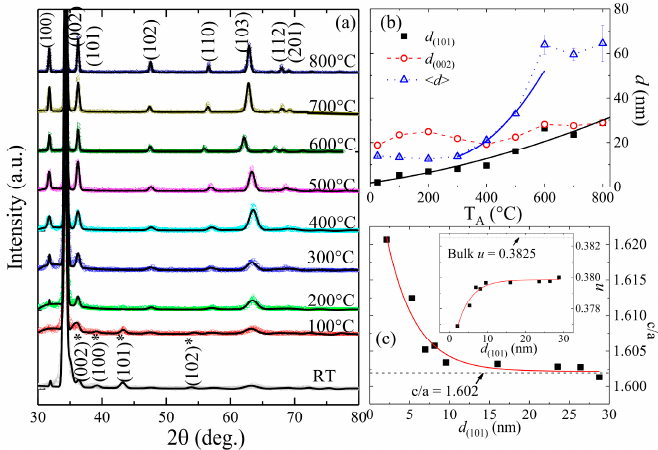
Figure 2. ( a ) “F(calc) weighted” LaBail extraction analysis [32] (solid line) for the X-ray diffraction (XRD) pattern (crosses) of the RT, and 100 to 800 °C annealed ZnO/ALO films (bottom to top) with Bragg reflections of ZnO and Zn (star-marked) phases indicated; ( b ) T A -dependency of d (002) , d (101) calculated from XRD patterns and the fitted values of < d > obtained from SEM images. Black colored solid lines represent the growth law fitting to d (101) ; ( c ) Grain-sized d (101) dependence of the ratio of lattice constants c / a , where the horizontal lines represent the value of bulk ZnO, and the solid line denotes the exponential fit. The inset in ( c ) shows the corresponding evolution of the internal parameter u .